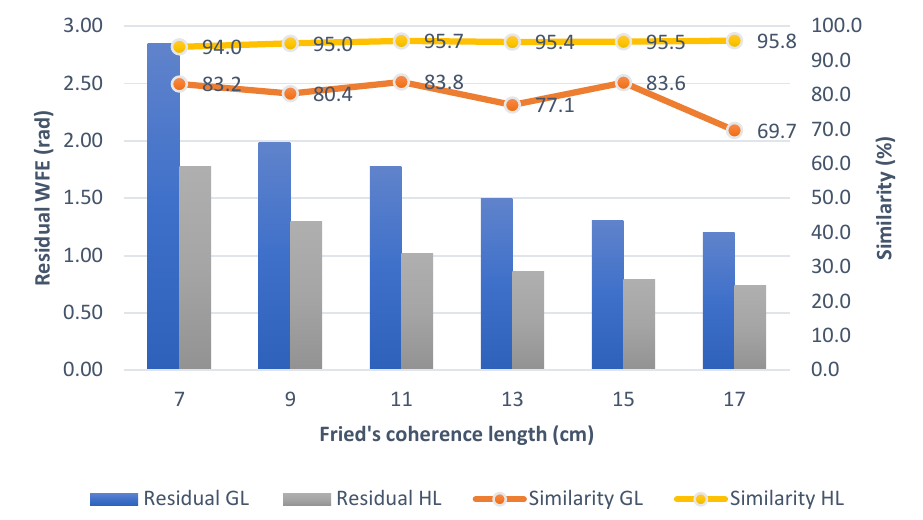
Figure 8. Influence of the height of the layers (ground layers (GL) and high-altitude layers (HL)) in the reconstructions carried out using the cross-correlations as inputs for the FCN for the several 𝑟 0 values tested. To make comprehension easier, the bars for each case are in the same order as the legend and each case has its own markers.